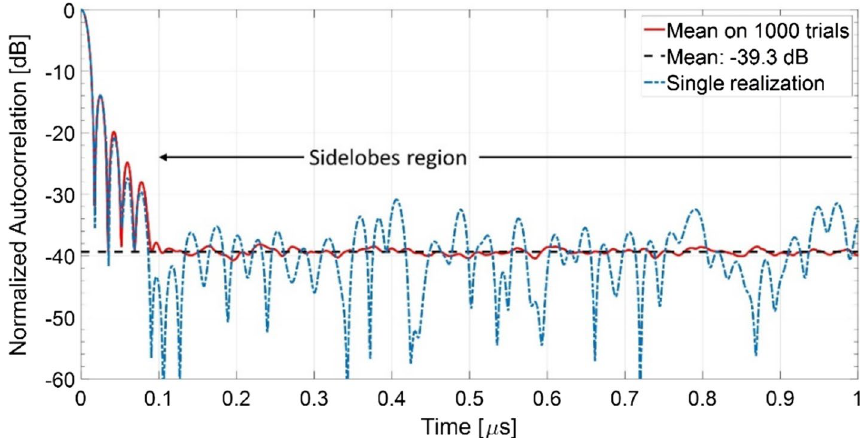
Fig. 9 Normalized ACF of an exemplary noise waveform with uniform power spectrum ( B T 109 μs). Comparison between a single realization (blue), the sample mean on 1000 trials (red) and the = mean value (black) in the sidelobes region( t ≅ 0.1 μs)